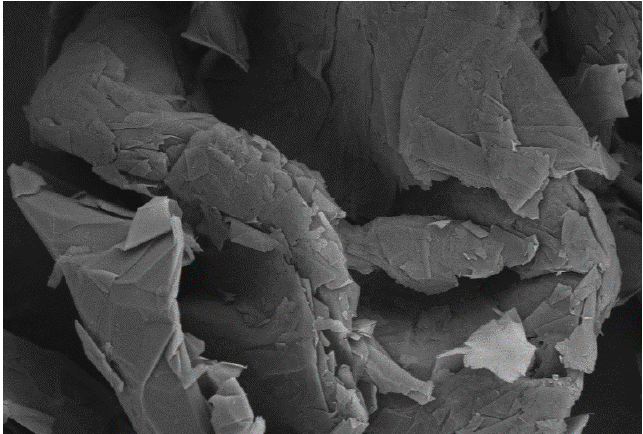
Figure 7. EG presents a layered structure under SEM.